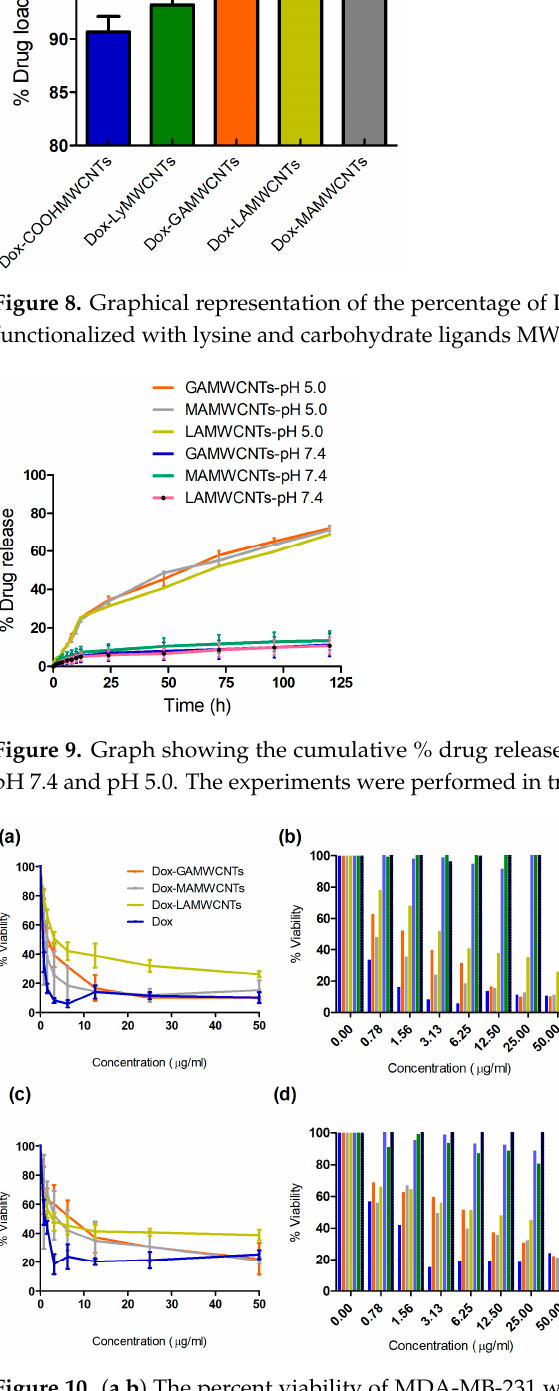
Figure 10. ( a , b ) The percent viability of MDA-MB-231 was determined using the MTT assay after 48 h of incubation with different concentrations of Dox-loaded formulations, pure formulations